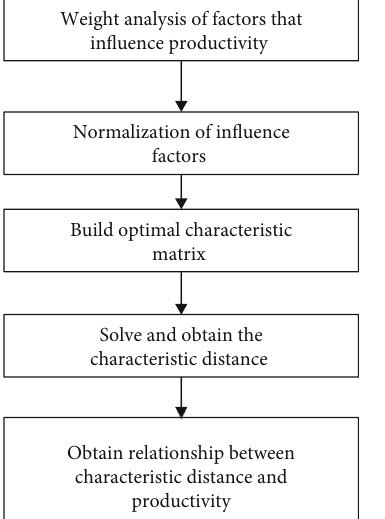
Figure 1: Flow diagram of productivity prediction using improved cluster analysis